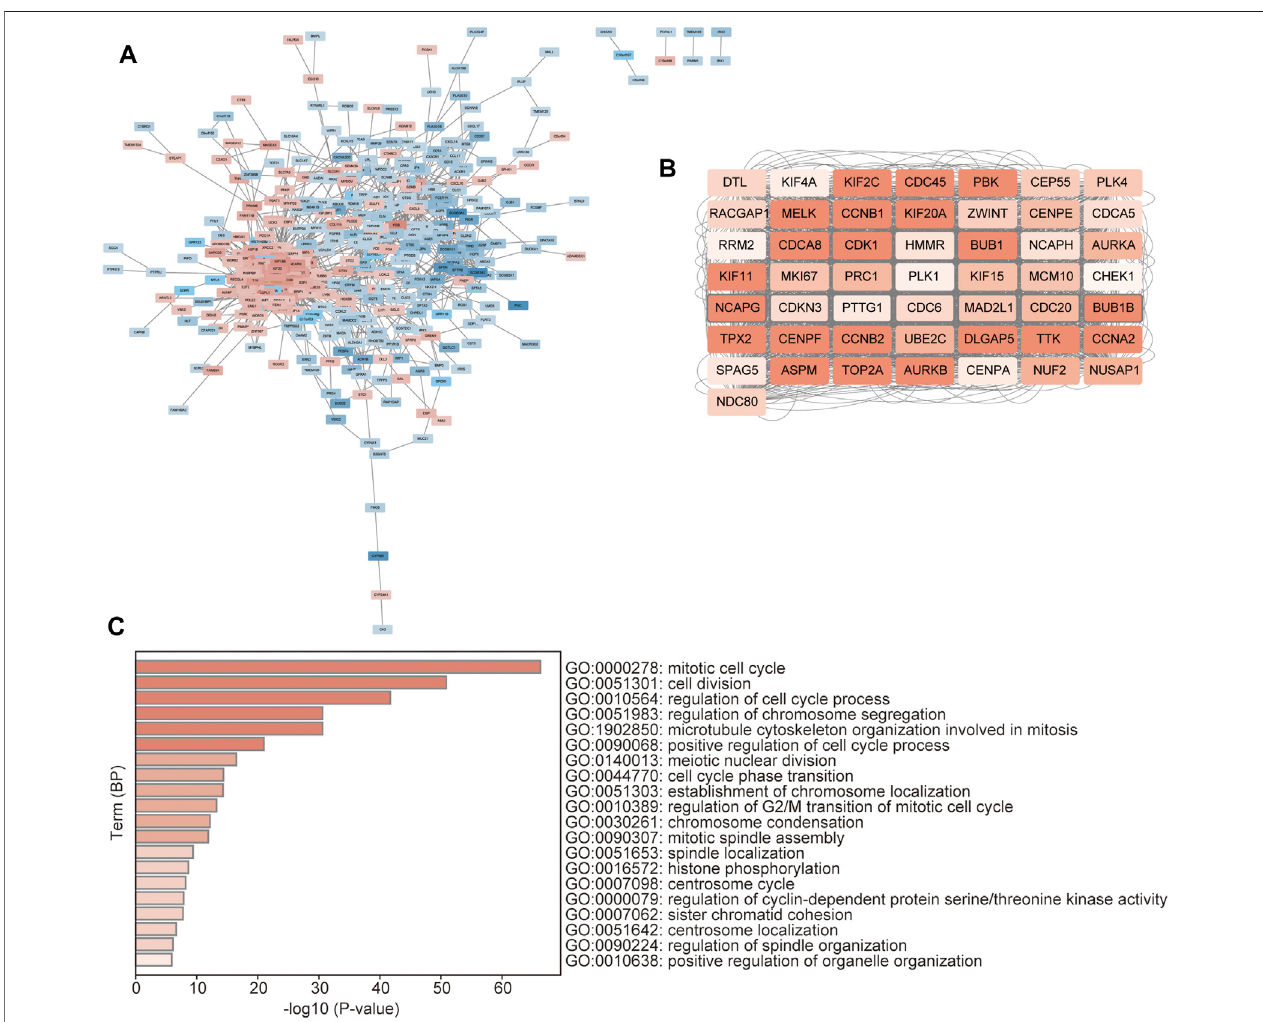
FIGURE 7 | Identi fi cation of hub-genes between the distinct clusters. (A) PPI network of the DEGs between the two clusters. The red represents the up-regulated genes, and the blue represents the down-regulated genes. (B) The network of the top 50 hub genes. The color depth represents the rank of the genes. (C) GO enrichment of the hub genes, which was performed by the Metascape database (https://metascape.org/gp/index).